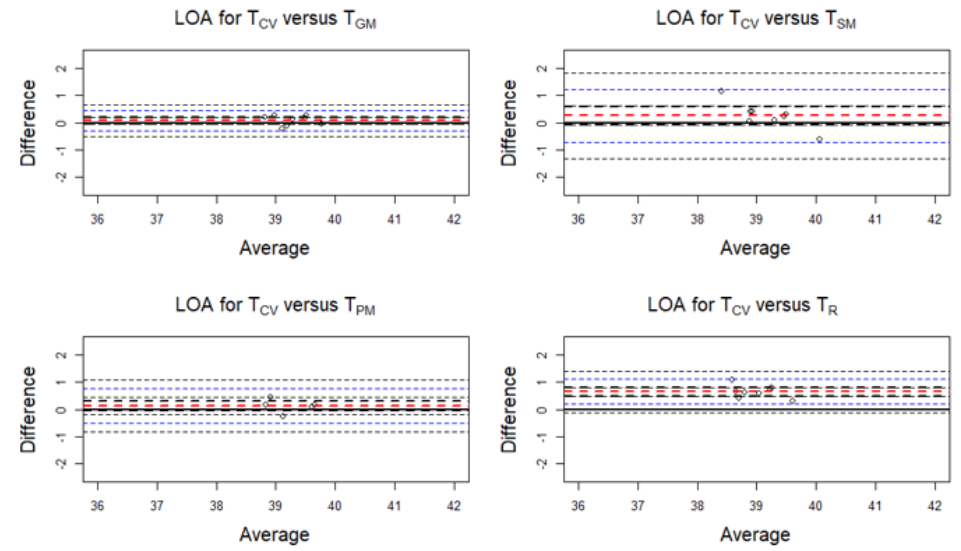
Figure 5. Limits of agreement (LOA) plots for the temperature pairs (T CV / T GM , T CV / T SM , T CV / T PM , and T CV / T R ) during Phase B (exercise on the treadmill). The red horizontal dashed line indicates the mean bias. The blue horizontal dashed lines indicate the upper and lower limits. The black horizontal dashed lines indicate the 95% confidence intervals of the LOA. T CV = central venous temperature, T PM = pectoral muscle temperature, T GM = gluteal muscle temperature, T SM = splenius muscle temperature, T R = rectal